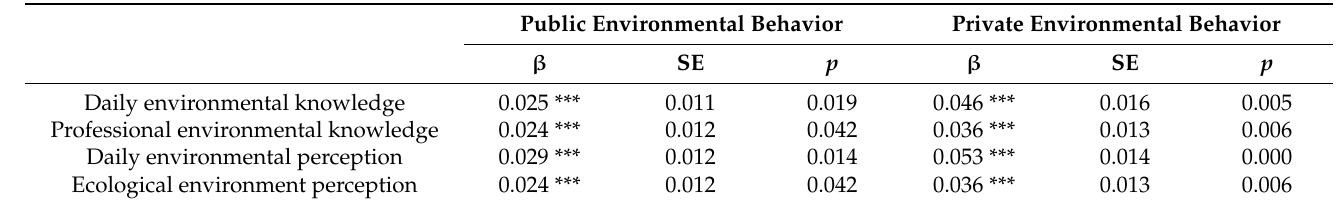
Table 3. Moderating effects of post-materialistic value on the